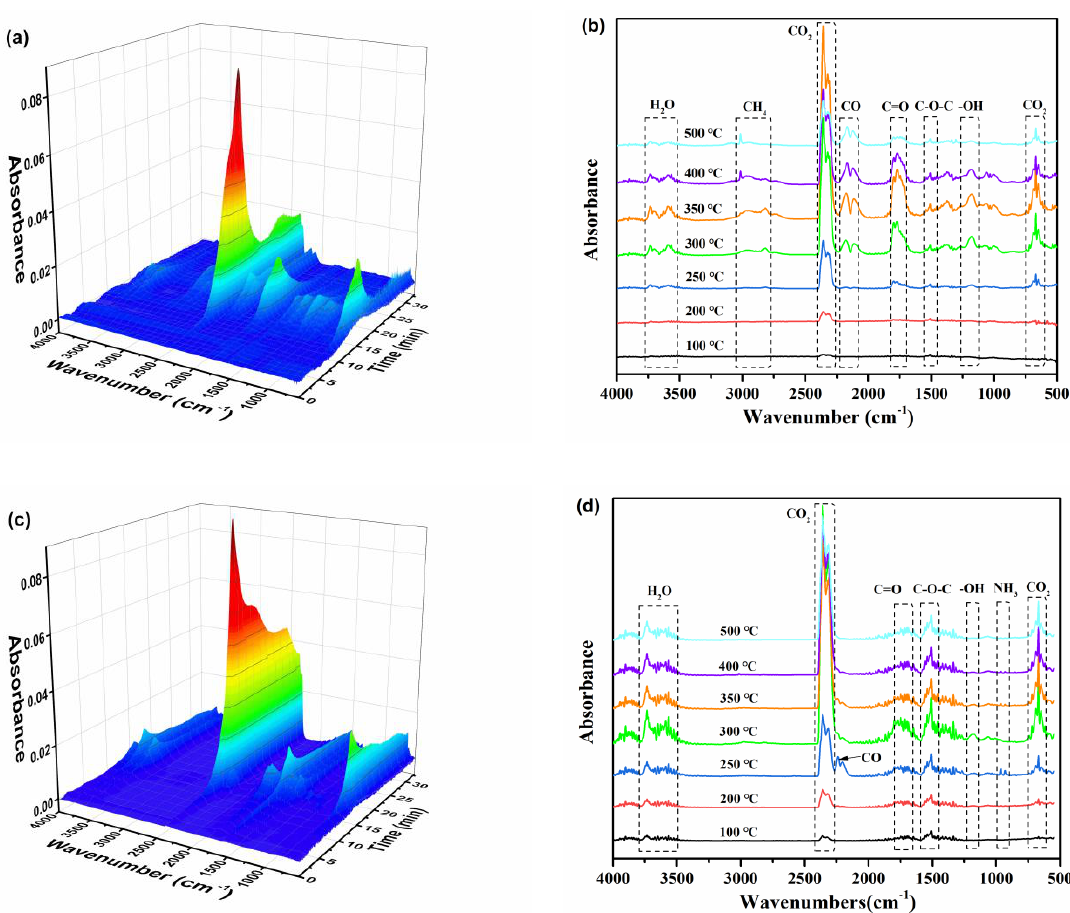
Figure 6. TG − IR spectra of the gas phase during combustion and the corresponding FT − IR spectra under different temperatures; ( a , b ) pure wood and ( c , d ) 10% GP-modified wood.